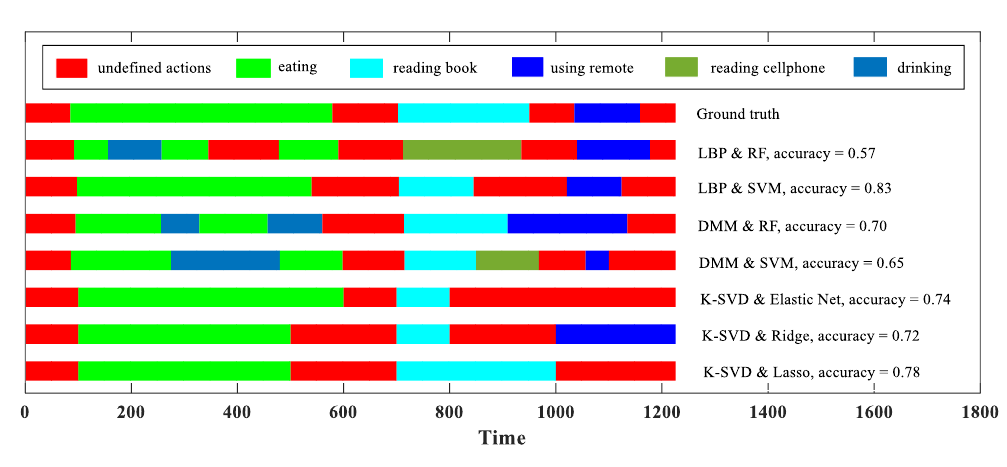
Figure 6. Visualization of online action recognition results.